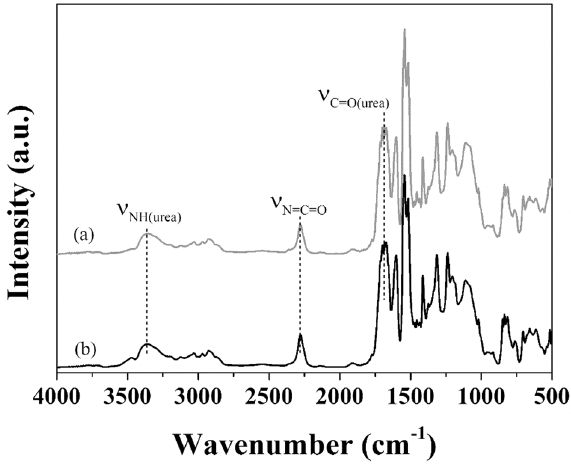
Figure 8. DRIFTS spectra of ( a ) modified and ( b ) non-modified SS/PU composites.